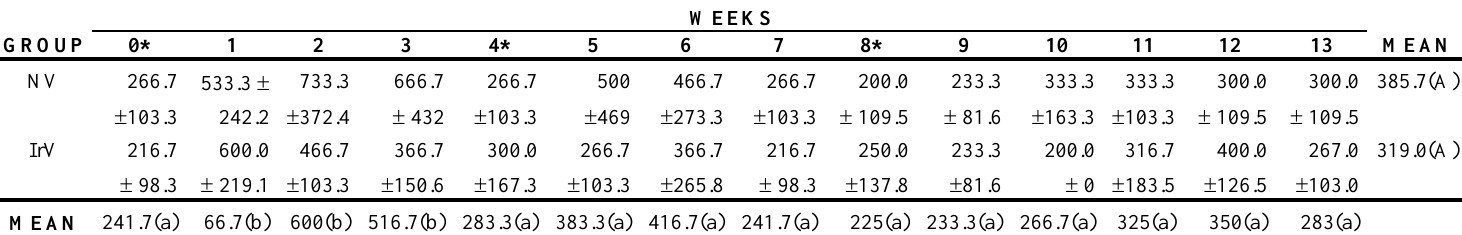
Table 5. Means and standard deviation of fibrinogen (mg/dL) in sheep (n=12) inoculated at days zero, 30, and 60 with natural (NV) and -irradiated (IrV) crotalic venom. Cobalt 60